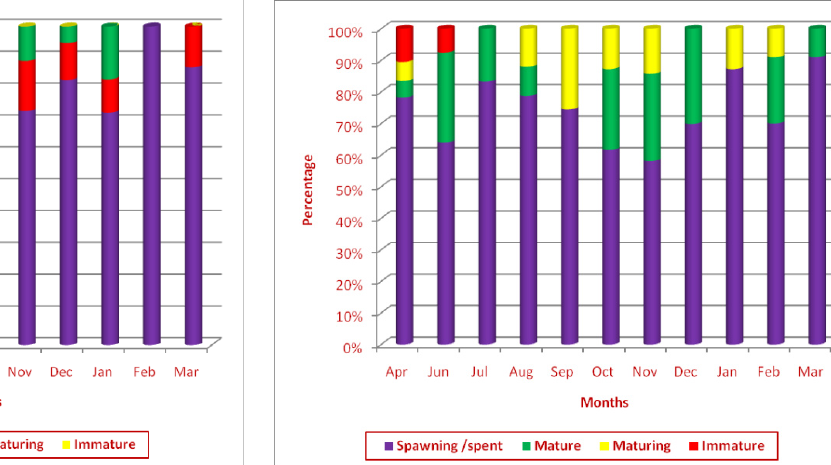
Fig. 3. Monthly stages of maturity of male of S. lessoniana Fig. 4. Monthly stages of maturity of female of S.